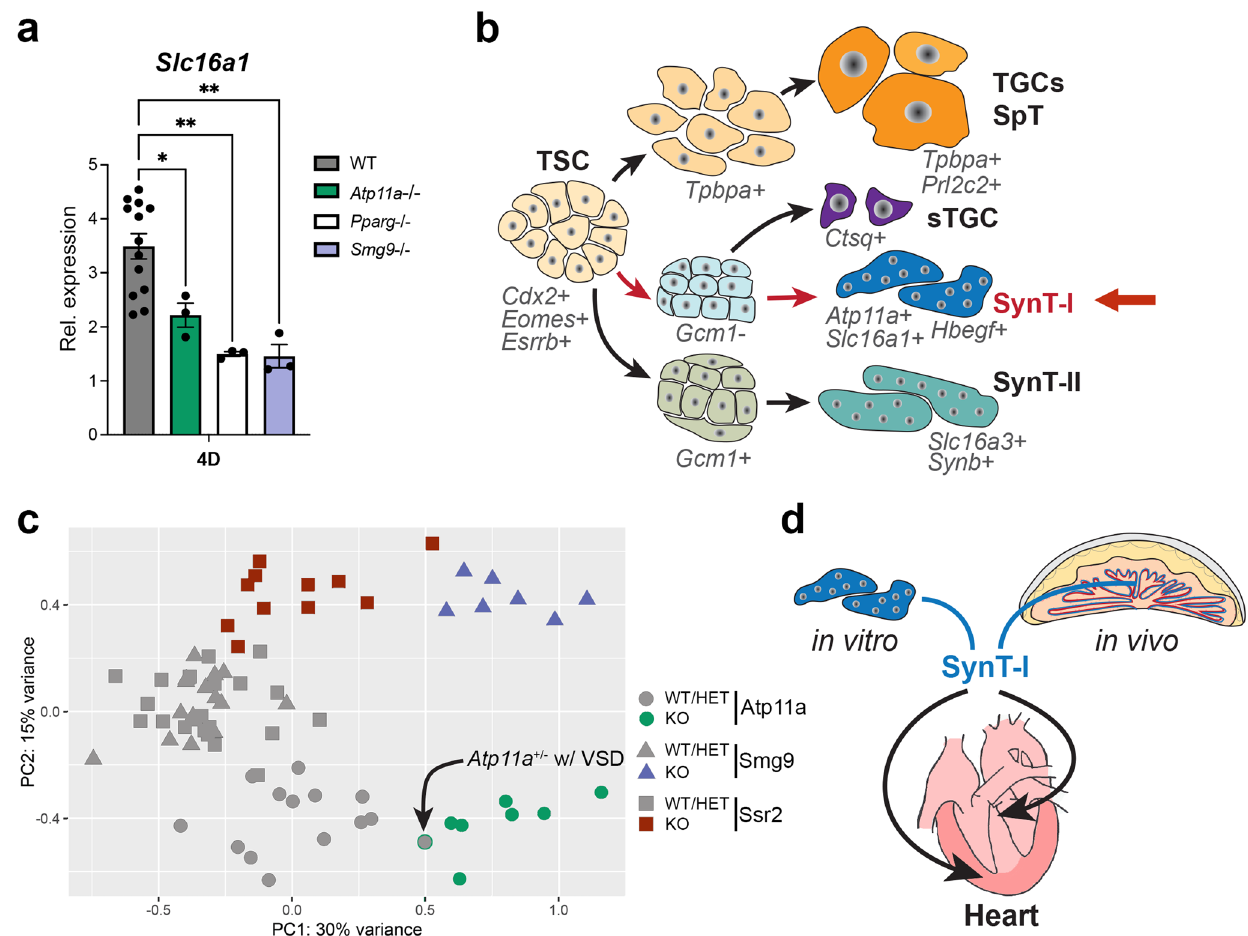
Fig. 7 | SynT-I defects correlate with cardiac pathologies. a RT-qPCR analysis of SynT-I marker Slc16a1 (=MCT1) in WT ( n =11), Atp11a - ( n =3), Pparg - ( n =3) and Smg9 -mutant ( n =3) TSC clones after 4 days of differentiation. Data are from independentcloneseach,displayedasmean±SEM(one-wayANOVA,Holm- Š ídák ’ s multiplecomparisonstest,* p <0.05,** p <0.01). b SchematicdiagramofmajorTSC differentiation trajectories, highlighting the SynT-I pathway compromised in Atp11a − / − , Pparg − / − , and Smg9 − / − TSCs. c Principal component analysis of bulk